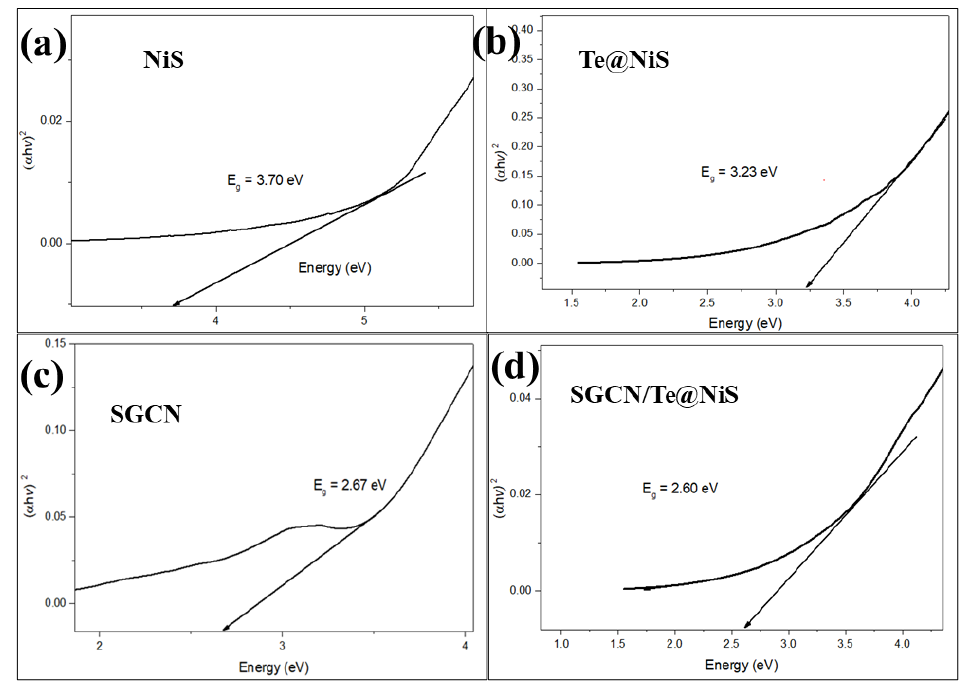
Figure 5. Tauc plots for band gap calculations ( a ) NiS, ( b ) Te@NiS, ( c ) SGCN, and ( d ) SGCN/Te@NiS.